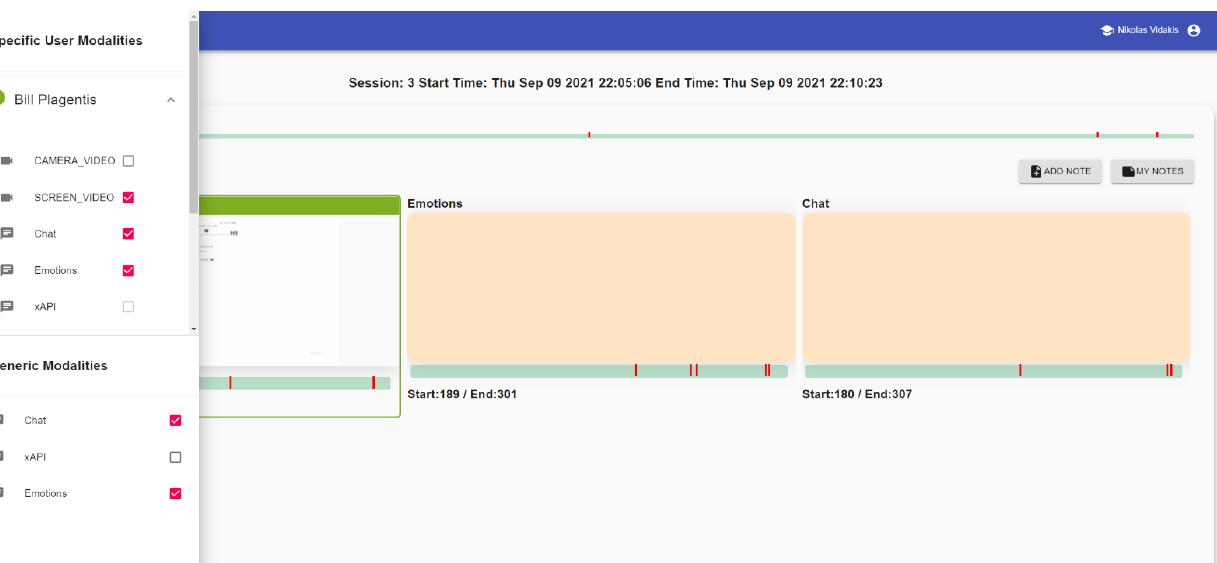
Figure 6. Open Studio View.